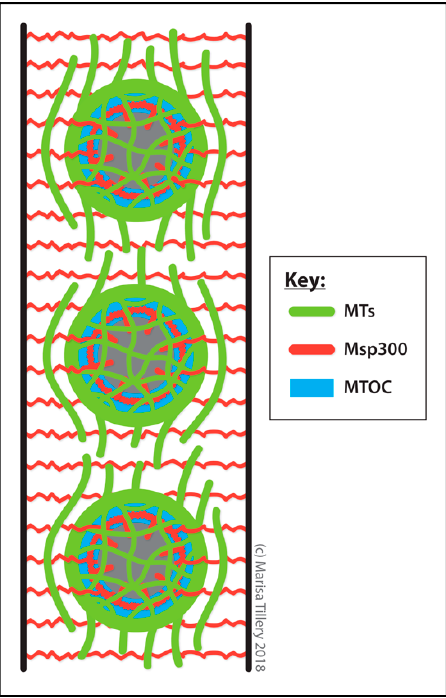
Figure 13. Perinuclear ncMTOC in muscle cells. The regular spacing of nuclei in multinucleate muscle cells requires the perinuclear ncMTOC.